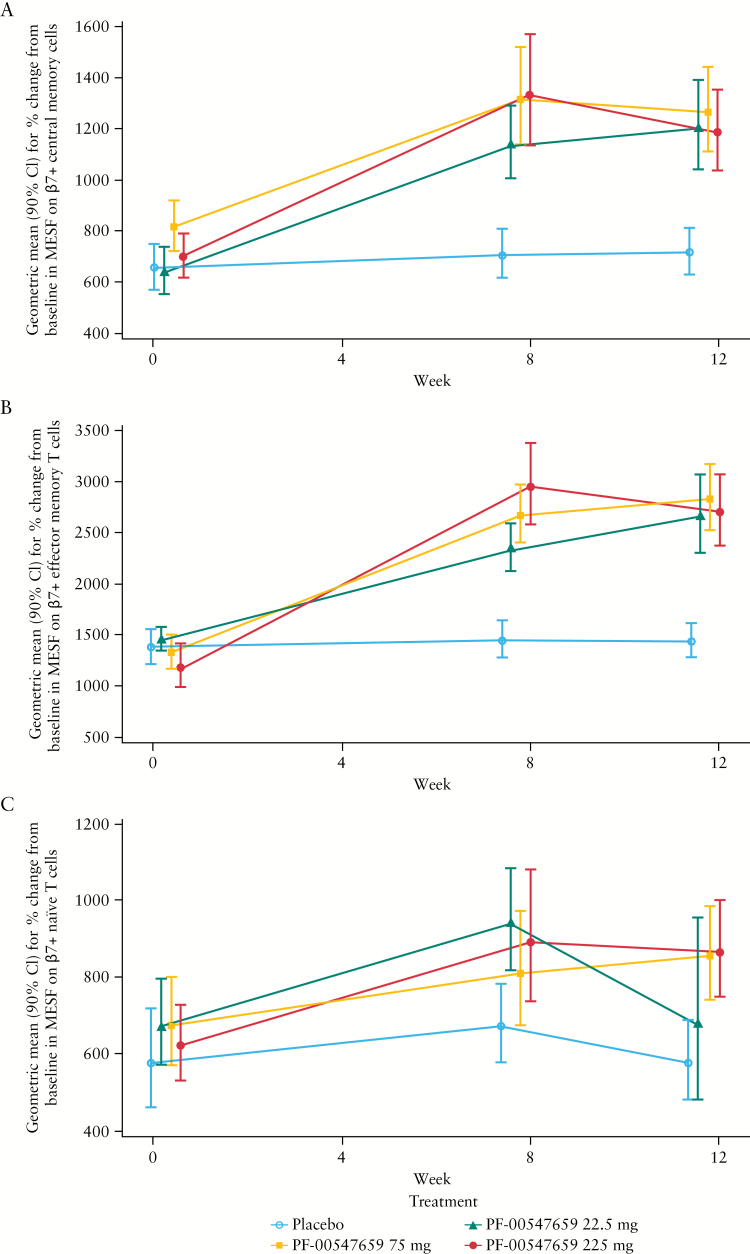
Effect of PF-00547659 on [A] β7+ central memory T cells; [B] β7+ effector memory T cells; and [C] β7+ naïve T cells, in CD4+ cell subsets of patients with CD. β7 expression was measured by a validated whole blood assay [see Supplementary Figure 1 for gating strategy]. The error bars are geometric mean estimates [90% CI] for percent change from baseline in MESF. CI, confidence interval; MESF, molecules of equivalent soluble fluorochrome.